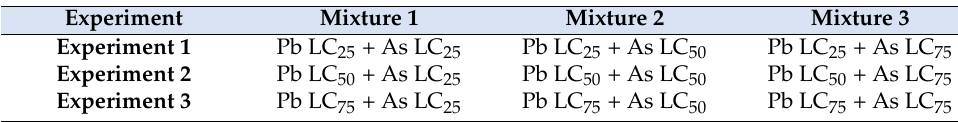
Table 1. Lead (Pb) and arsenic (As) mixture titration experimental design. Experiment Mixture 1 Mixture 2 Mixture 3 Experiment